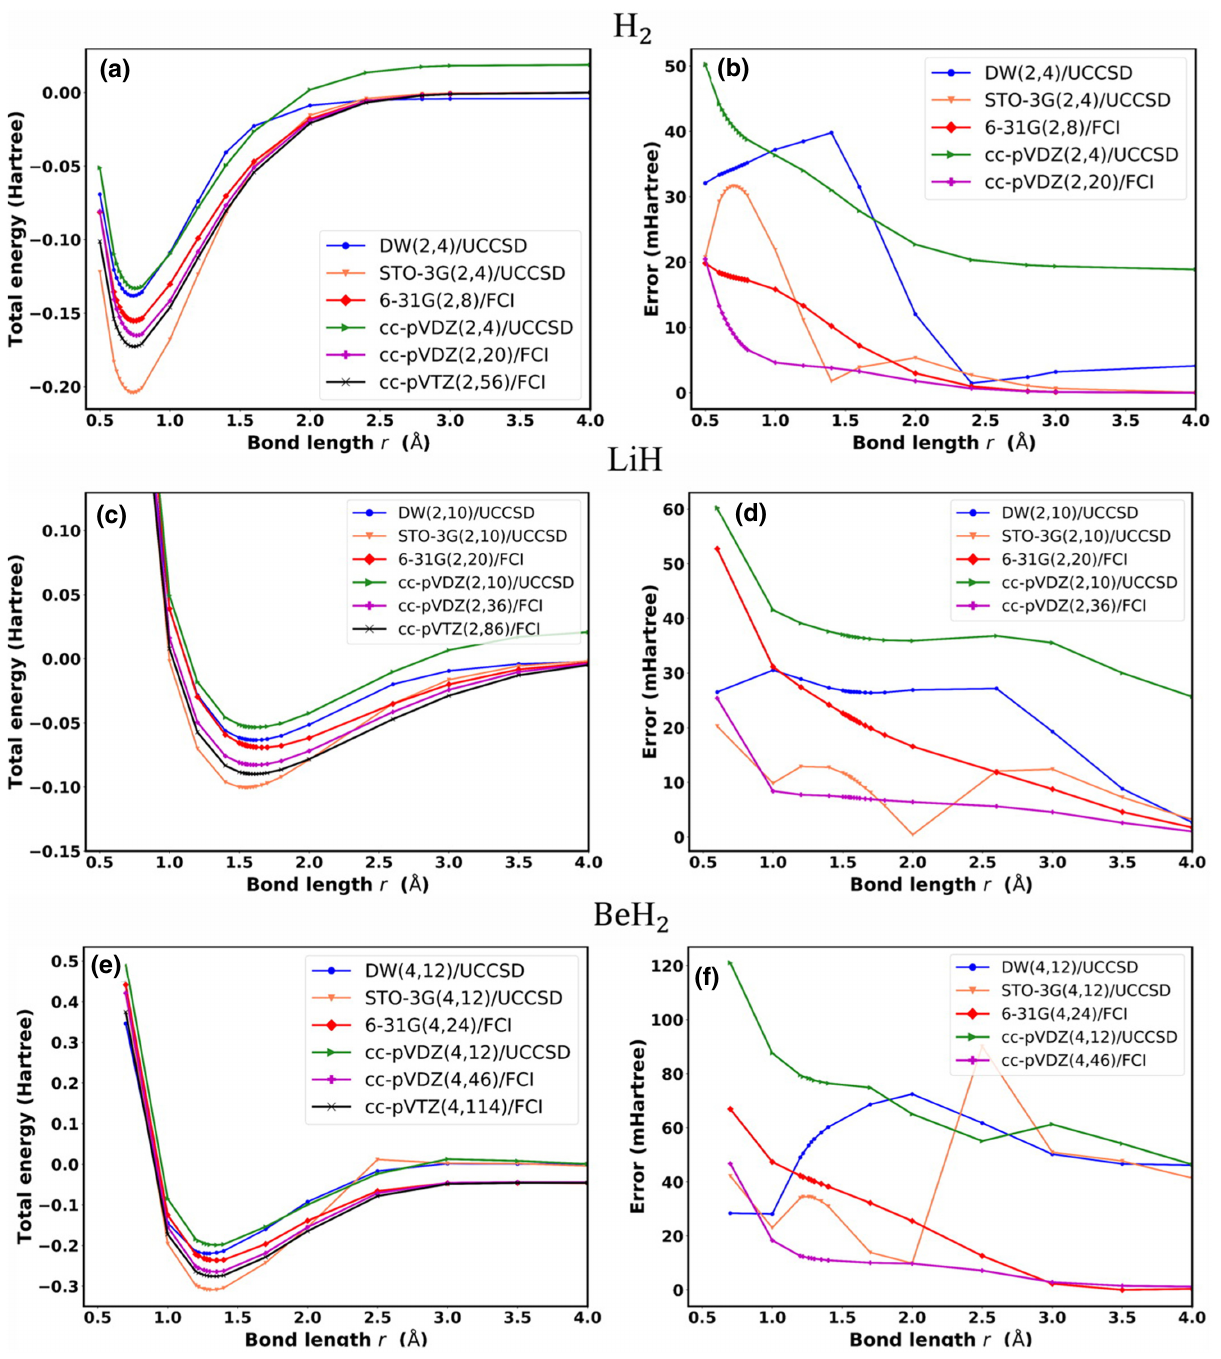
FIG. 1. Potential energy curves in (a),(c), and (e) and corresponding errors in (b),(d), and (f) for H 2 , LiH, and BeH 2 , respectively. The potential energies are computed with VQE on a quantum computer simulator or by exact diagonalization (FCI) on a classical computer. All curves are denoted with basis ( N e , N orb )/ method, where N e and N orb represent the numbers of electrons and spin orbitals, respectively. The error is defined as the absolute energy difference with respect to the ground-state energy value from the exact diagonalization (FCI) in the largest affordable Gaussian basis set of cc-PVTZ (in black curve) considered here. The position of the minimum energy and the curvature near the minimum of the potential energy curve give the equilibrium bond length and vibrational frequency of the molecule, respectively. Note that we use the same number of spin orbitals as the STO-3G minimal basis set for the minimal DW basis and the cc-PVTZ* basis with unoccupied orbitals